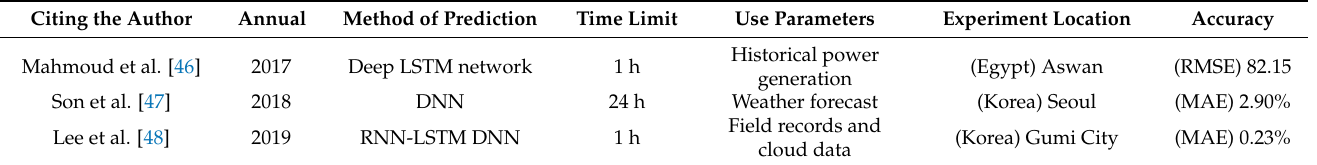
Table 1. 2017–2019 Experimental results based on deep learning and applied to solar power